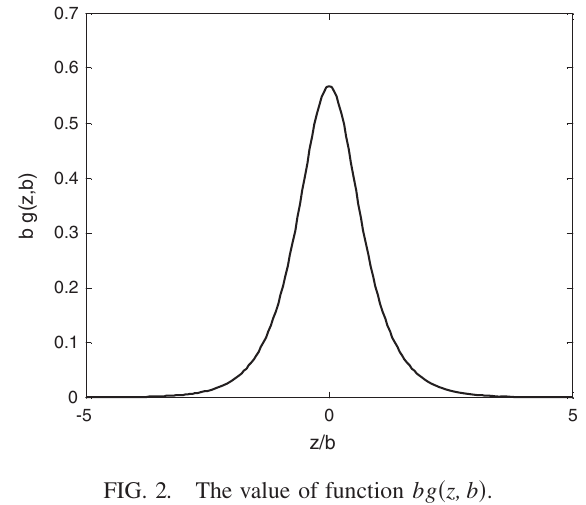
FIG. 2. The value of function bg ð z; b Þ